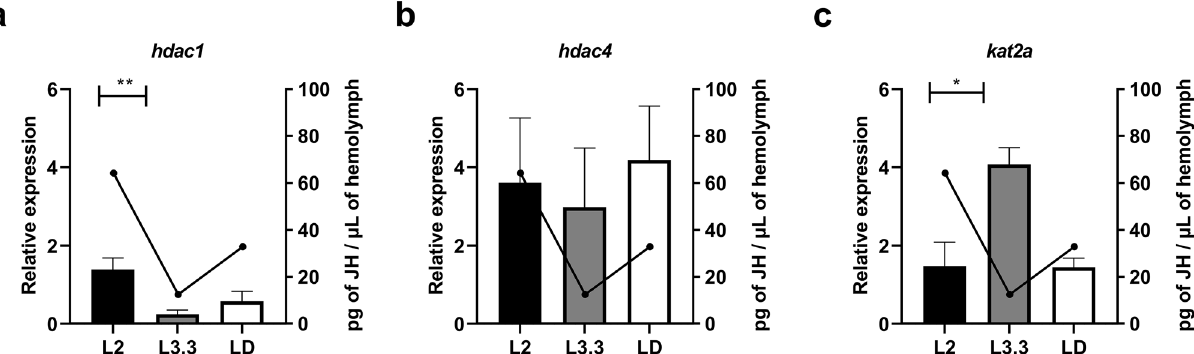
Figure 1. Comparison between expression of HDACs and HAT genes and JH titers in Melipona scutellaris larvae. The graphs show the overlapping of relative expression of hdac1 ( a ), hdac4 ( b ), and kat2a ( c ) quantified by RT-qPCR and JH titers quantified by radioimmunoassay. L2 = larva of the second stage; L3.3 = larva of the third stage in the third instar; LD = defecating larva. The graphs show mean ± SEM (n ≥ 5). Statistical